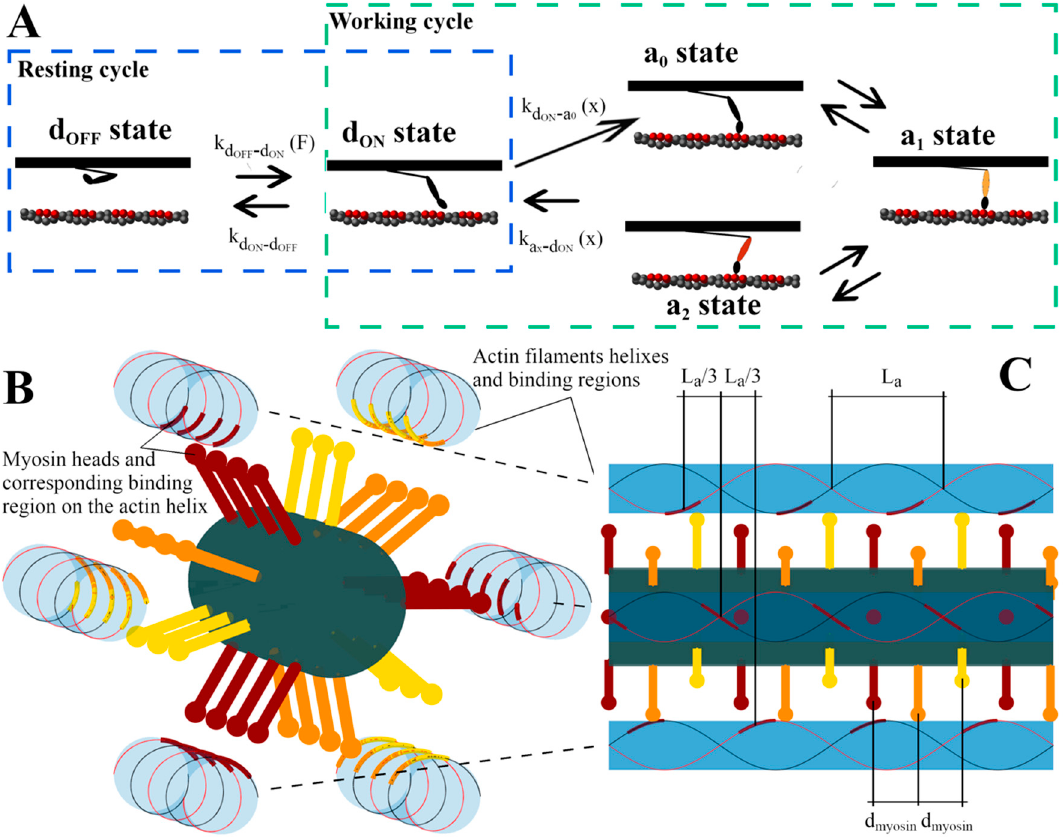
Figure 1. Cross-bridge cycle and pseudo-replication of the 3D structure in the model. ( A ) The cross-bridge cycle where, in an otherwise classical model, the super-relaxed state in myosin motors is taken into account, splitting the whole cycle into a resting cycle for the activation of the thick filament and a working cycle, where a two-step power stroke generates force. The activation rate depends on the force acting on the thick filament (see Equation (6)). The attachment and detachment rates depend on the relative position of the motor with respect to its anchor (Equations (7) and (8)). ( B ) 3D structure of one thick filament surrounded by six thin filaments; 4 crowns of motors are shown. The two helixes on the thin filaments are indicated along with the available binding regions, highlighted with the color of the corresponding motor heads. ( C ) Lateral view of the 3D structure. Only the binding regions for the deep red motors are indicated, showing 𝐿 (cid:3028) /3 shifts (see Section 4.1). The mismatch between actin-binding regions and the motors can be particularly appreciated in the motors pointing out of the figure plane toward the viewer (deep red dots in the middle of the figure) and the corresponding binding regions. The first head from the left is pointing exactly to the center of the binding region. The second is more displaced but still within it. The third and fourth heads cannot attach because of the geometrical hindrance.